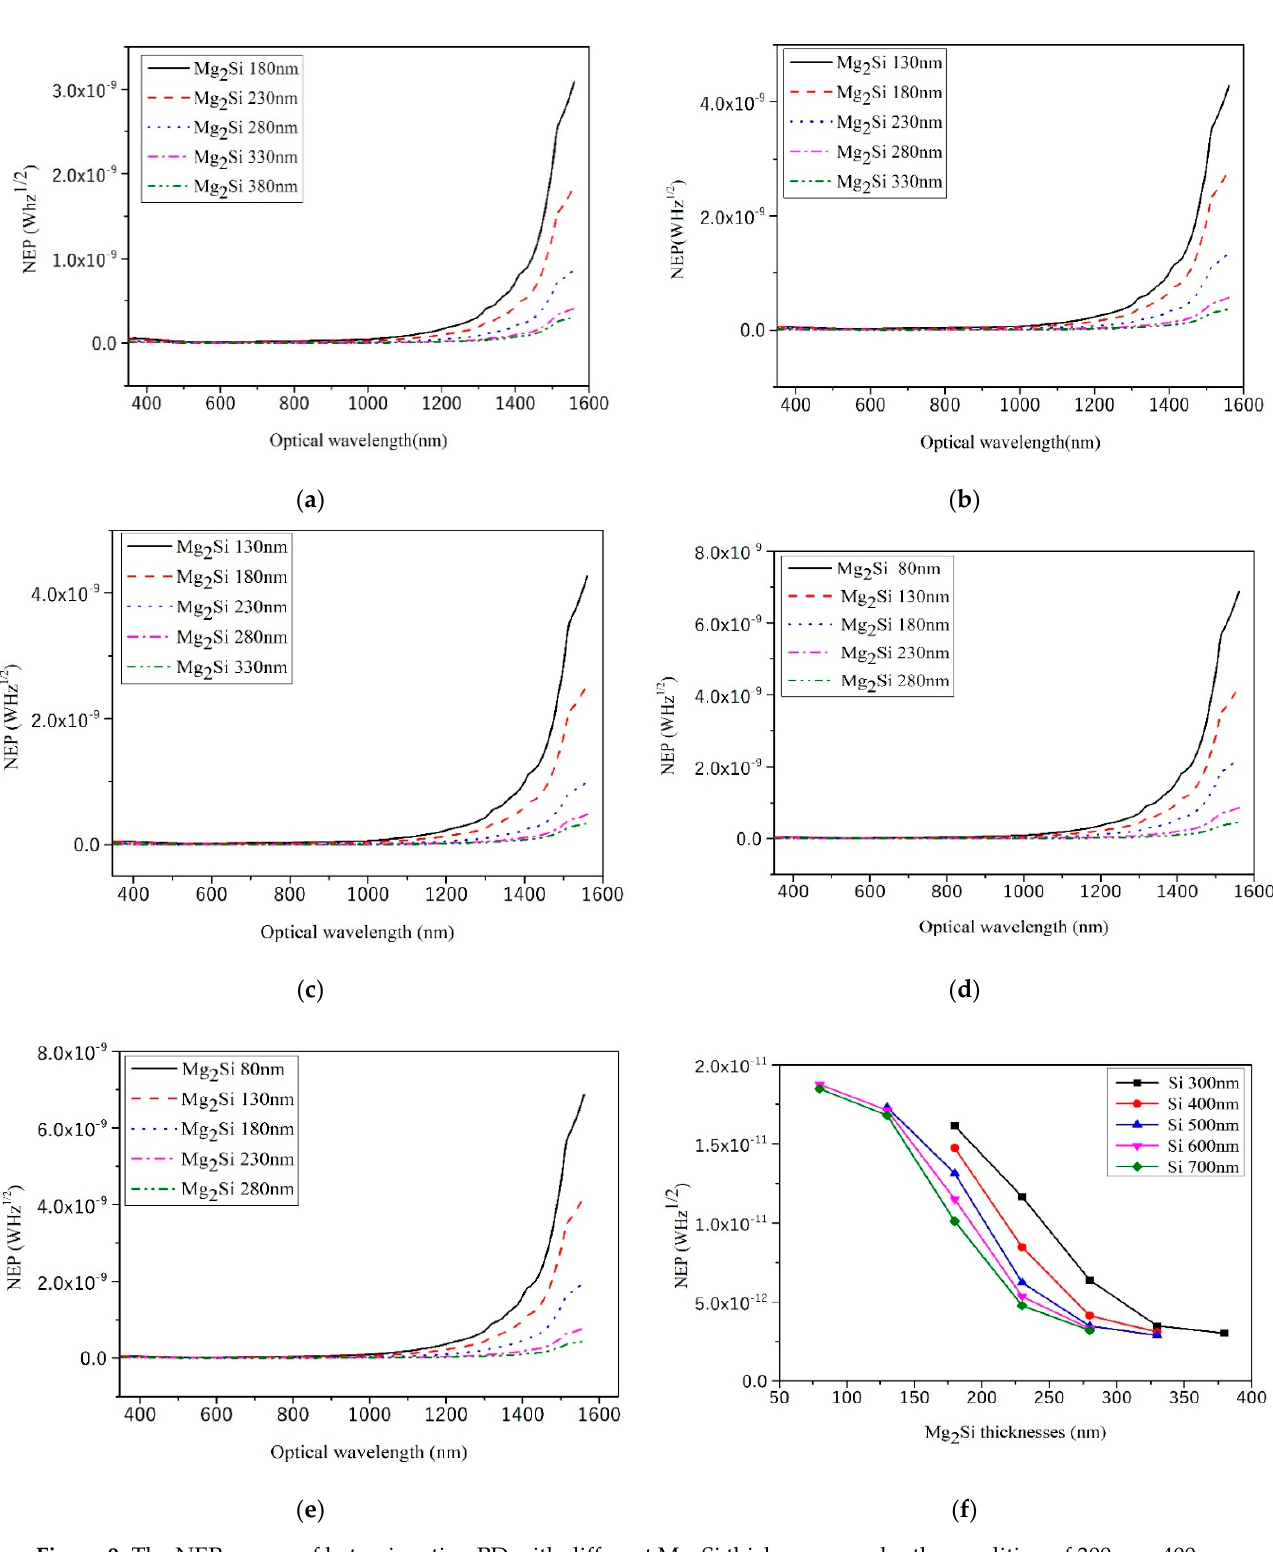
Figure 9. The NEP curves of heterojunction PD with different Mg 2 Si thicknesses under the condition of 300 nm, 400 nm, 500 nm, 600 nm, and 700 nm thicknesses of Si. ( a ) Si-300 nm; ( b ) Si-400 nm; ( c ) Si-500 nm; ( d ) Si-600 nm; ( e ) Si-700 nm; ( f ) The effect of thicknesses on the NEP.